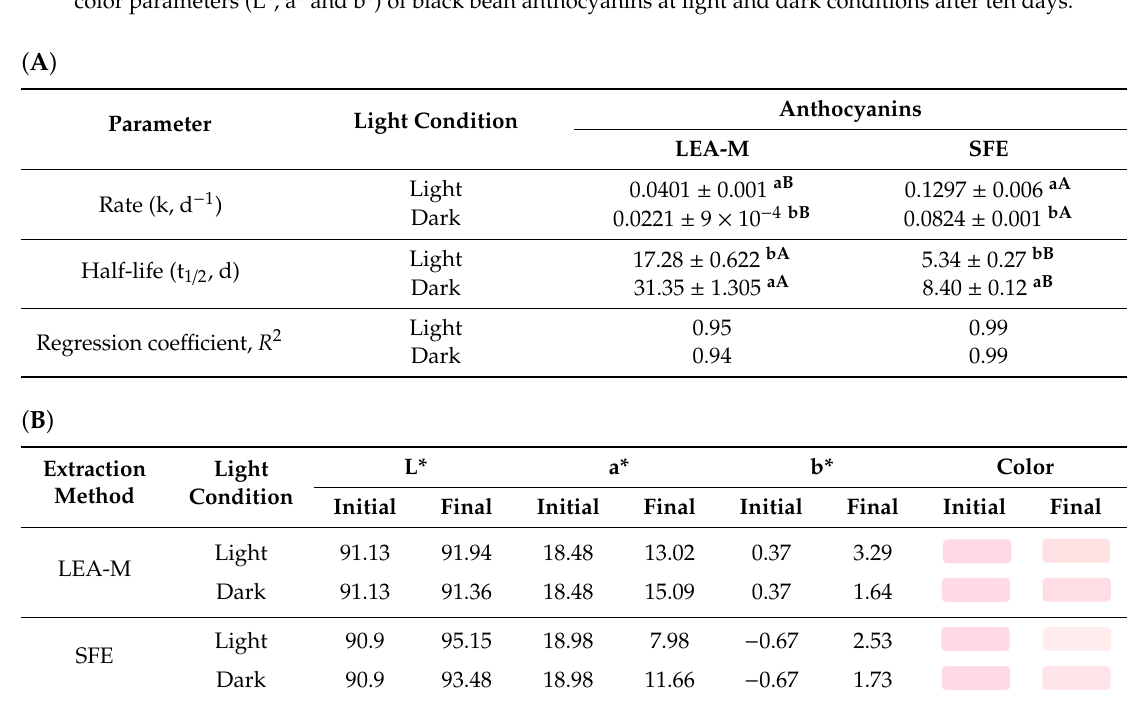
LEA-M: Leaching extraction of manually husked bean coat, SFE: Supercritical fluid extraction, D: Days. Different lowercase letters show significant differences within the same sample under distinct light condition, while different uppercase letters show significant differences among samples under the same light condition ( p < 0.05, two-sample t -test). The results are shown in mean ± standard error.